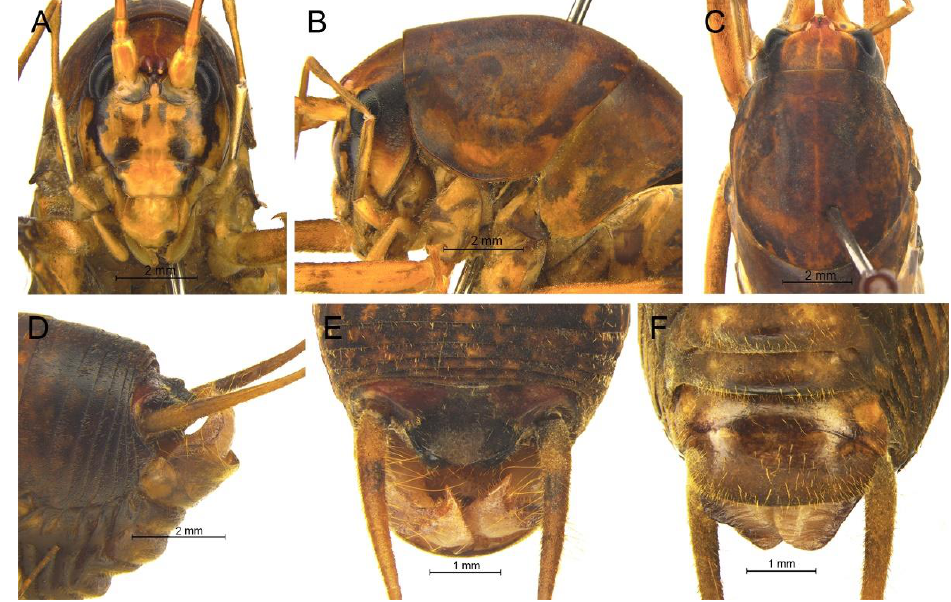
Figure 21. Homotachycines triangulus Zhu & Shi sp. nov., male: ( A – C ) head and pronotum: ( A ) frontal view, ( B ) lateral view, ( C ) dorsal view; ( D – F ) apex of abdomen: ( D ) lateral view, ( E ) dorsal view, ( F ) ventral view.